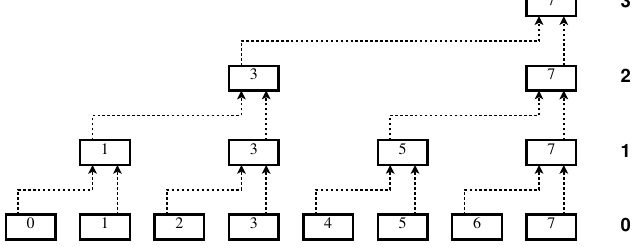
Figure 1. Schematic representation of the hierarchical evaluation.